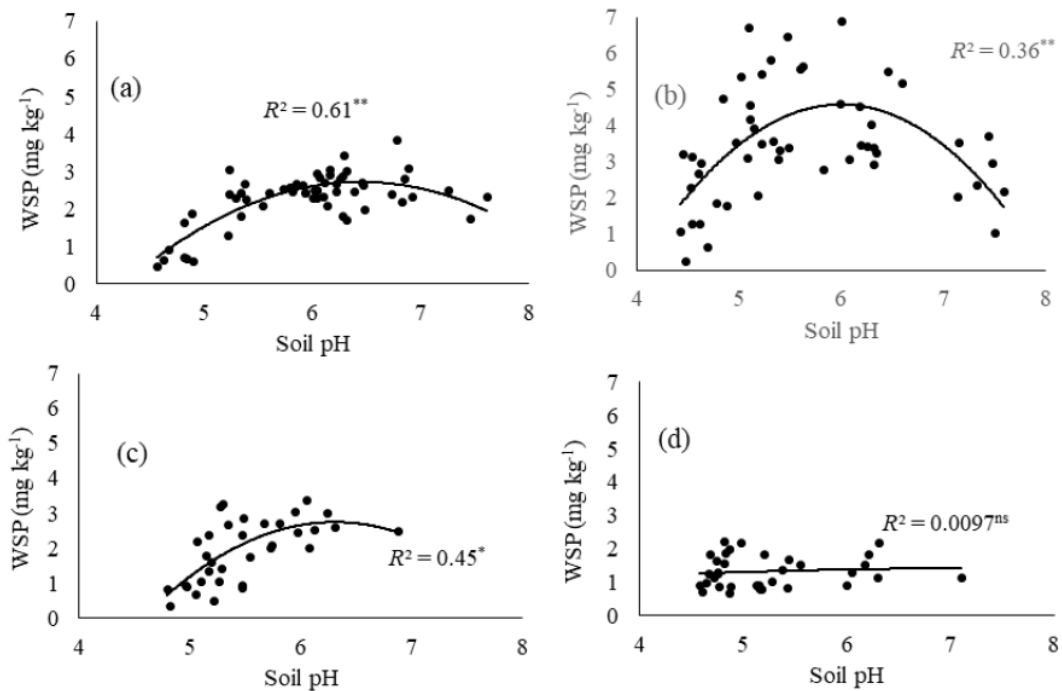
Figure 1. Relationship between soil pH and water-soluble phosphorus (WSP) for each location: ( a ) Chickasha, ( b ) Efaw, ( c ) Lahoma, and ( d ) Perkins. Total soil P was constant within each location. **, *: indicates significance at p < 0.01 and 0.05, respectively, for the second-order linear regression model. ns: not significant.